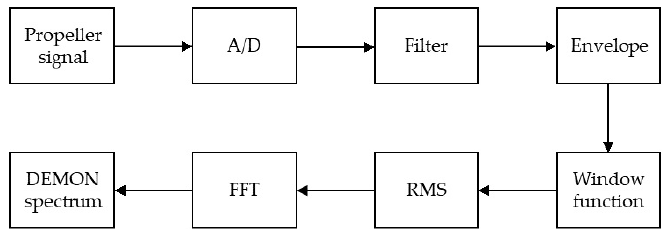
Figure 1. The orginal DEMON algorithm